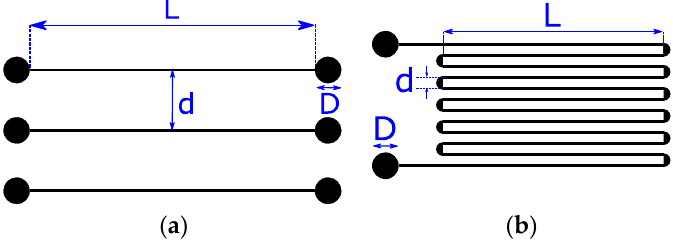
Figure 1. Geometric pattern of the printed devices adopted to test the proposed method: ( a ) Three lines 3.5 mm apart (d), 13 mm long (L) with 1.2 mm diameter pads (D); ( b ) serpentine pattern with lines 10 mm long (L) and 1.2 mm diameter pads (D).